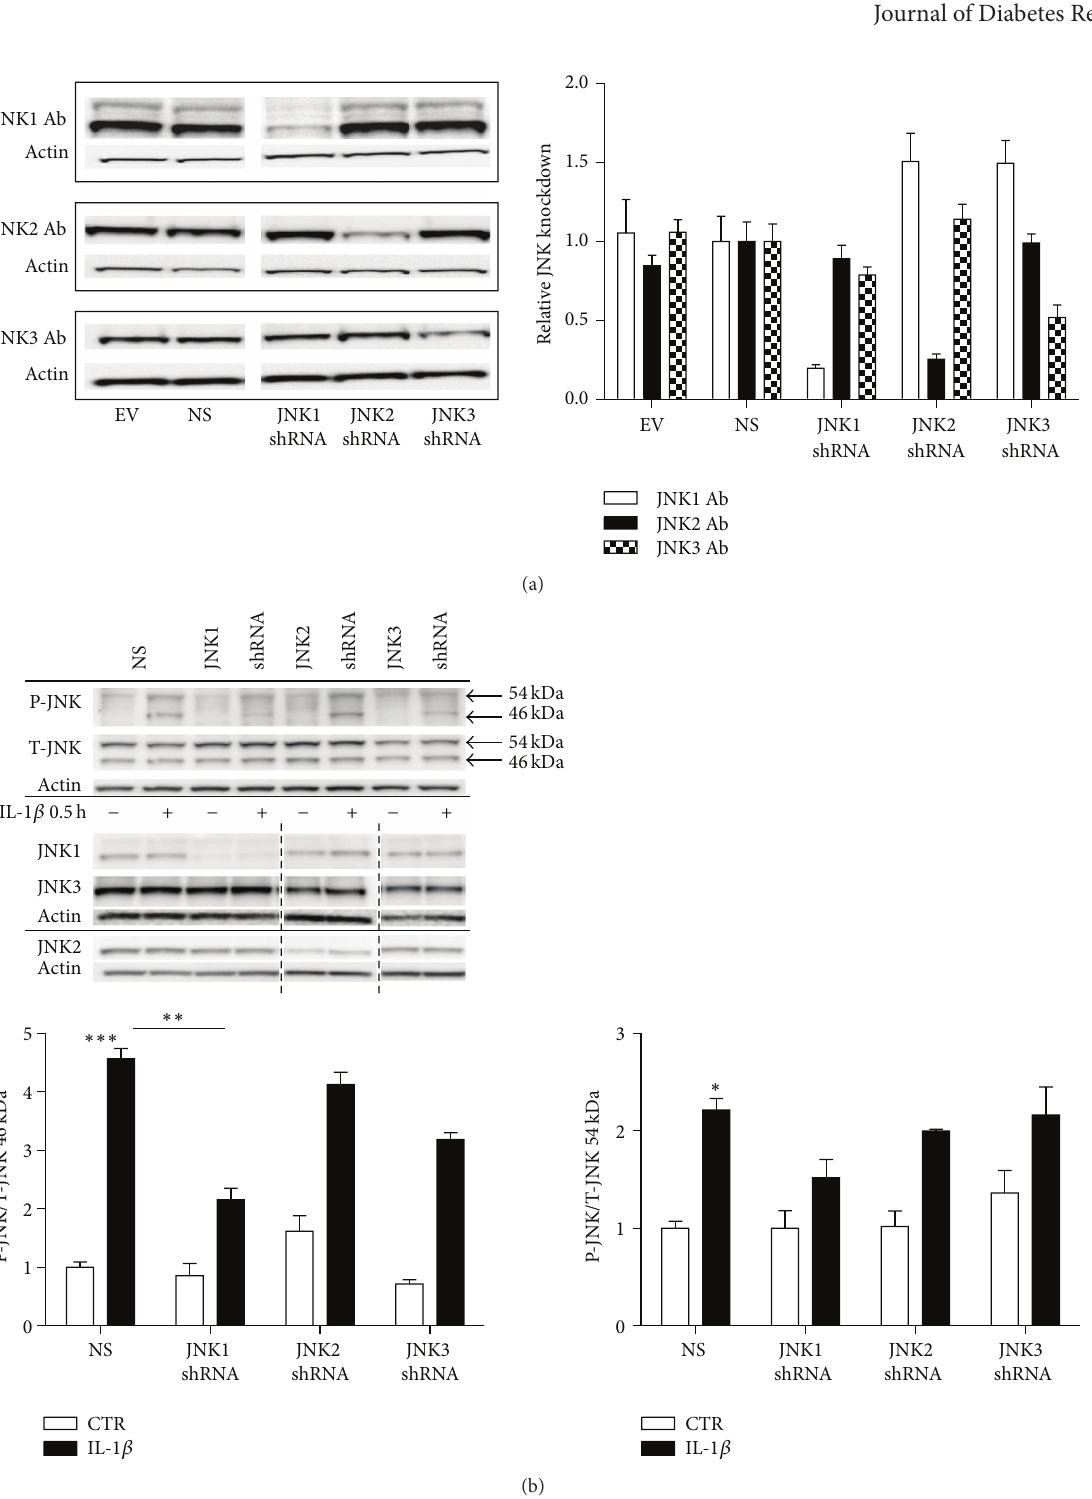
Figure 3: Phosphorylated JNK in individual JNK subtype knockdown INS-1 cell lines exposed to IL-1 𝛽 for 0.5 h. INS-1 cells were transduced with Lentivirus containing shRNA directed against JNK1, JNK2, or JNK3 and nonsense (NS) or empty vector (EV) controls. Cells stably expressing the shRNA plasmids were selected with puromycin. (a) Stable INS-1 cell lines expressing shRNA for JNK1, JNK2, JNK3, nonsense shRNA, or empty vector controls were cultured for 4 days, protein was isolated, and JNK1, JNK2, and JNK3 protein knockdown expression was analyzed by immunoblotting. Data are shown as means ± SEM of 𝑛 = 3 independent experiments. Representative blots are shown. (b) Stable INS-1 cell lines expressing shRNA for JNK1, JNK2, JNK3, nonsense shRNA, or empty vector were exposed to 150 pg/mL IL-1 𝛽 (closed bars) or vehicle (open bars) for 0.5 h. P-JNK was assessed with immunoblotting and normalized to T-JNK. Data were quantified in respect to 46 kDa and 54 kDa P-JNK/T-JNK. Data are shown as means ± SEM of 𝑛 = 3 independent experiments. Specific knockdowns of the individual JNK subtypes, JNK1, JNK2, or JNK3, are shown with their respective actin. Blots were cut as indicated by the dotted black line. ∗ 𝑃 < 0.05 , ∗∗ 𝑃 < 0.01 , and ∗∗∗ 𝑃 < 0.001 versus IL-1 𝛽 exposed NS. Representative gels are